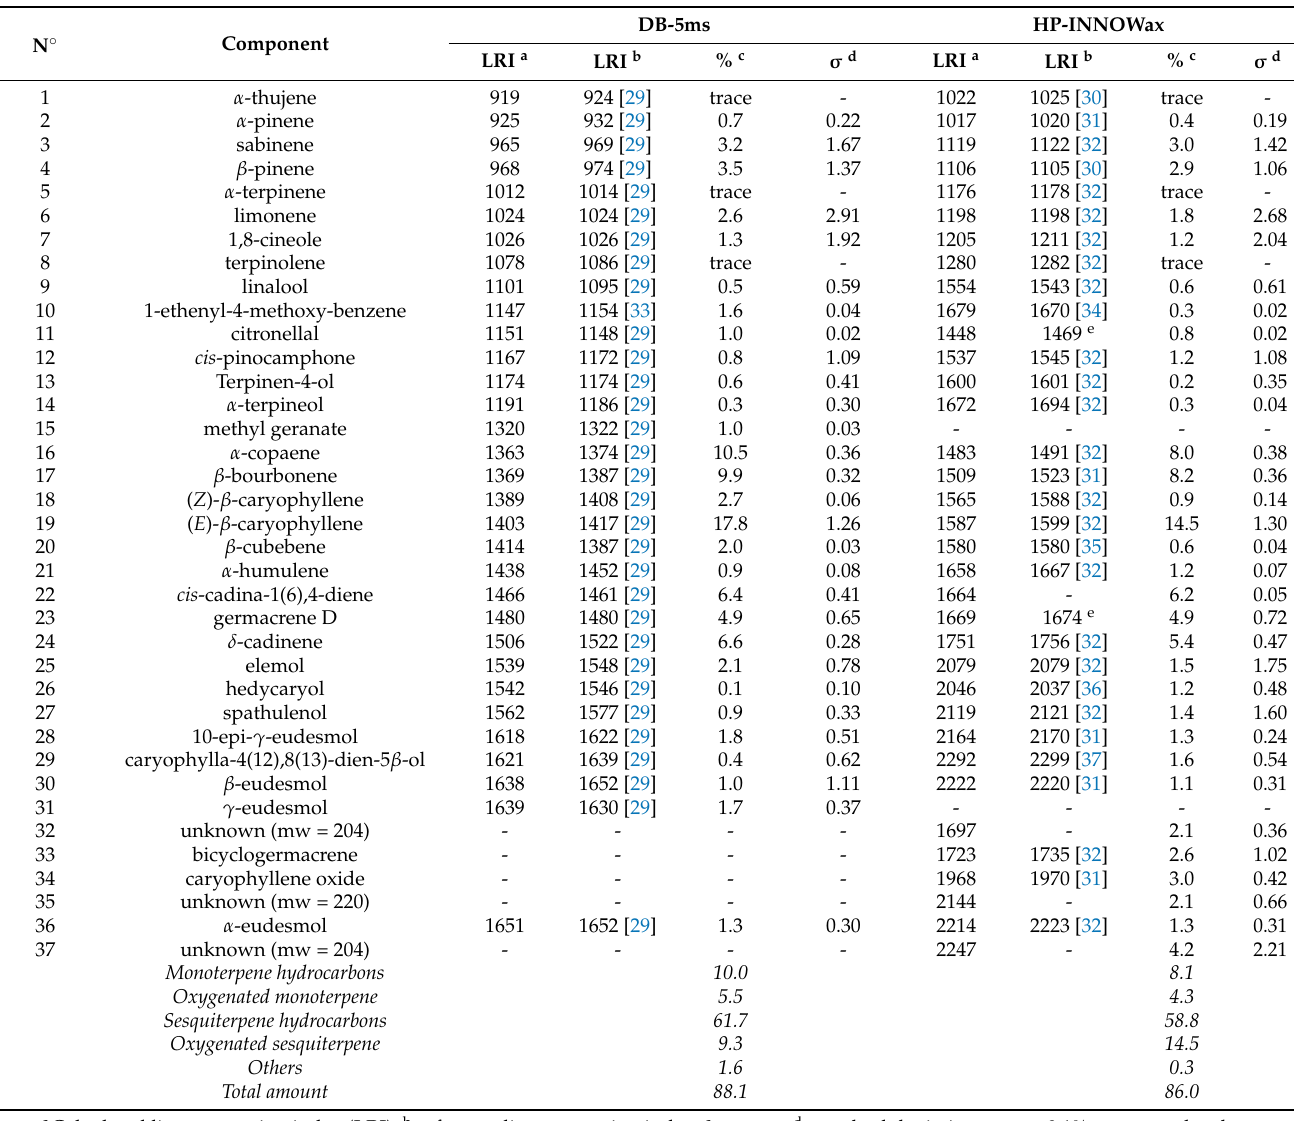
Table 1. Chemical composition of C. taxifolium EO with 5%-phenyl-methylpolysiloxane (DB-5ms) and polyethylene glycol (INNOWax)